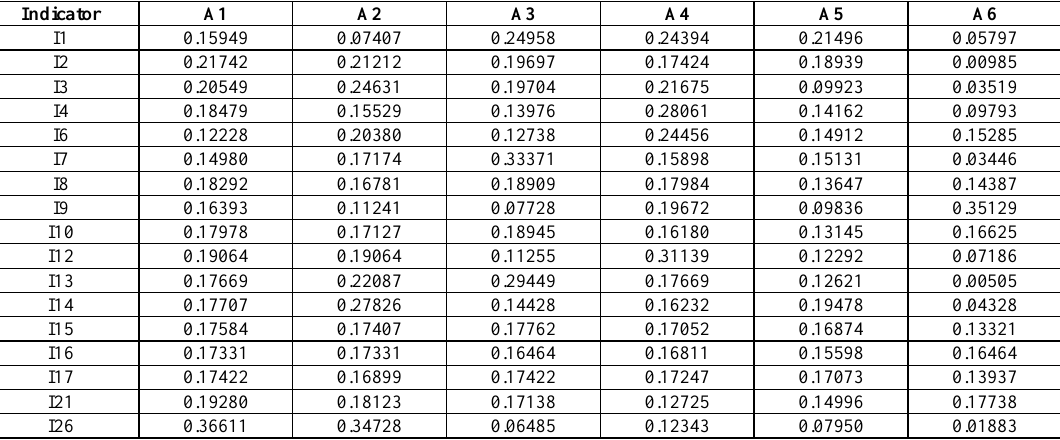
Table 3. Normalized quantitative